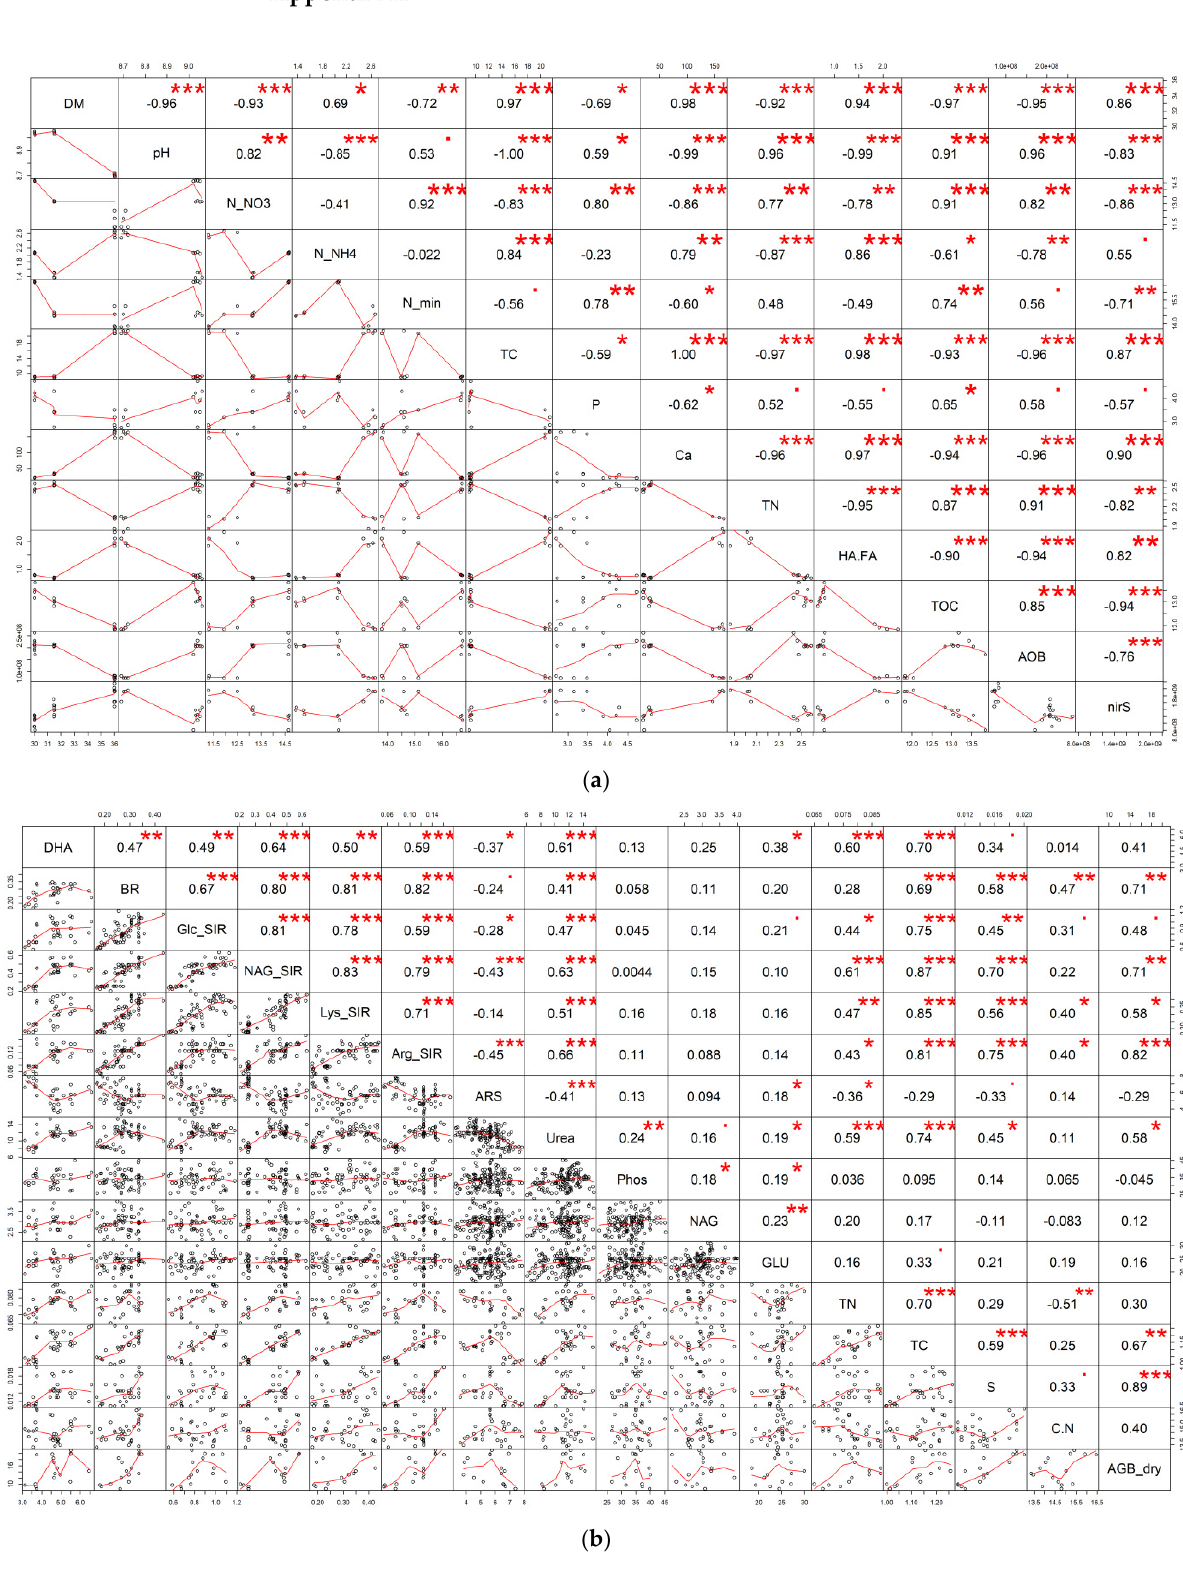
Figure A1. The Pearson’s correlation matrix of ( a ) matured manure properties and ( b ) soil and plant properties; values indicate a correlation coefficient (r). Explanation: · Significant at 0.10 level; * Significant at 0.05 level; ** Significant at 0.01 level; *** Significant at 0.001